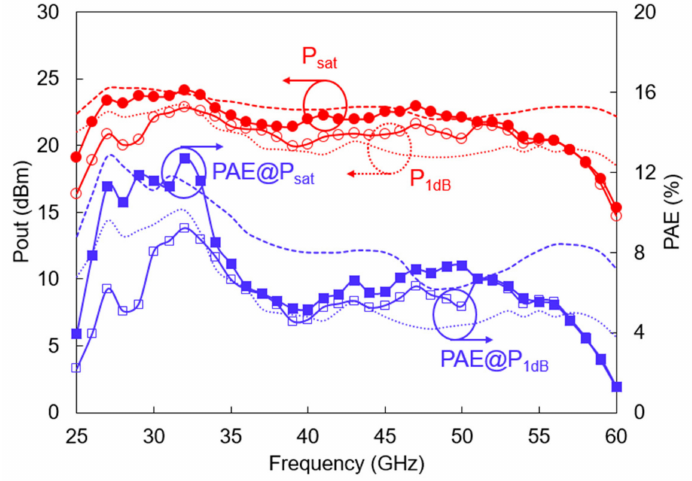
Figure 10. P sat , P 1dB , and PAEs at P sat and P 1dB of the proposed PA according to frequencies (solid line: measurement, dashed line: simulation).